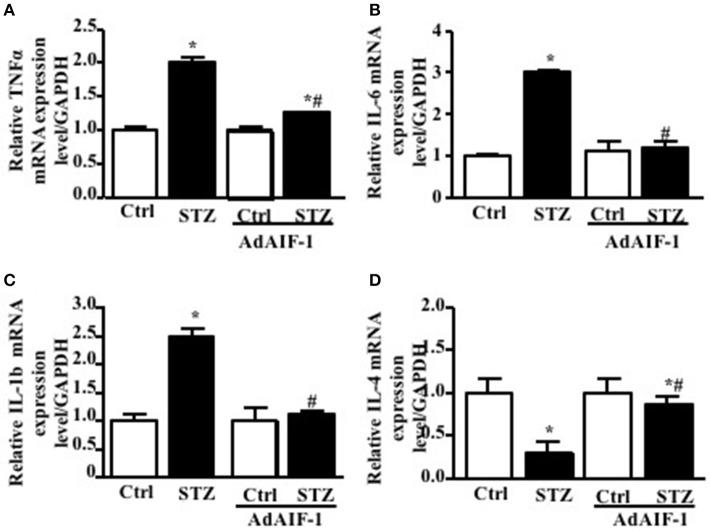
AIF-1 overexpression decreased inflammation in diabetic mice hearts. (A) TNFα level, (B) IL-6 level, (C) IL-1β level, (D) IL-4 level. Data are expressed in mean ± SEM (*p < 0.05 Ctrl vs. STZ; #p < 0.05 STZ vs. AdAIF-1 STZ), n = 6.